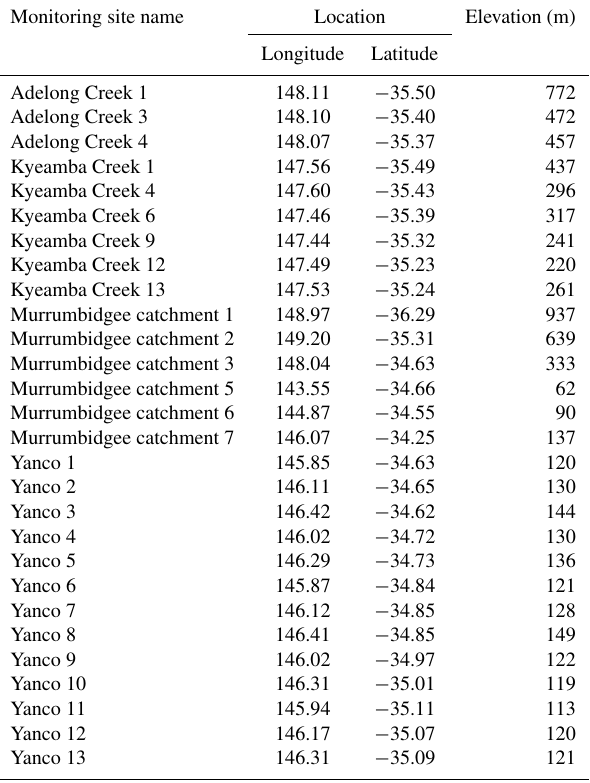
Table 2. Soil moisture monitoring sites’